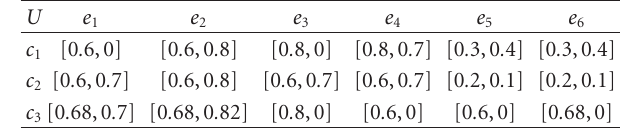
Table 1: Representation of truth-membership function of ( (cid:2) F , A ).